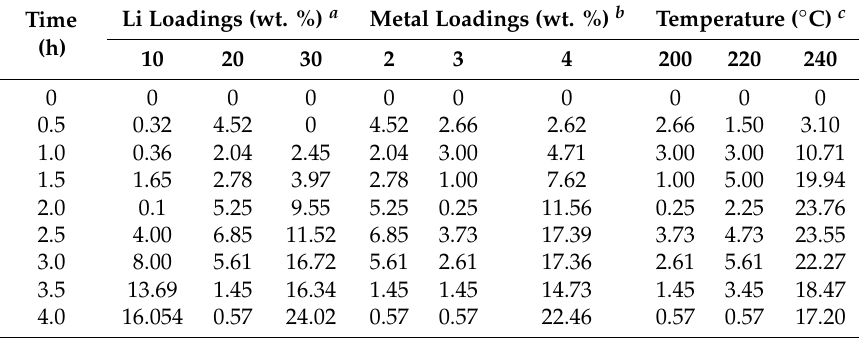
Table 3. Long-chain polyglycerol yields for di ff erent reaction